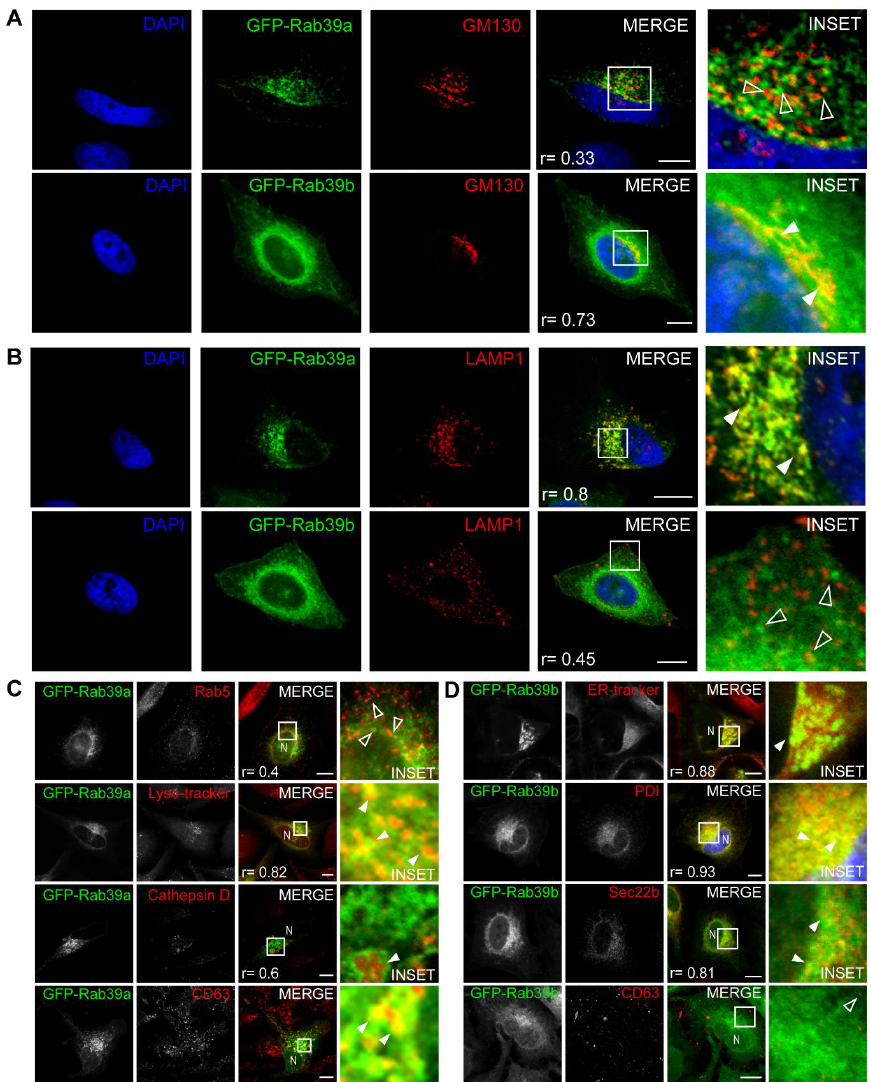
Figure 2. Rab39a and Rab39b intracellular distribution. ( A , B ) HeLa cells overexpressing GFP-Rab39a ( top ) or GFP-Rab39b ( bottom ) were incubated with anti-GM130 ( A ) to detect the cis -Golgi matrix protein or with anti-LAMP1 ( B ) to detect late endosomes. Cy3-labeled IgG was used as secondary antibody (red). DNA was stained with DAPI (blue). ( C ) Labeling of different intracellular structures of the endocytic pathway with typical probes (lyso-tracker) or specific antibodies (Rab5, Cathepsin D or CD63) followed by the appropriated secondary Cy3-coupled IgG (red) in HeLa cells overexpressing GFP-Rab39a. N indicates nuclei. ( D ) Identification of different intracellular organelles of the secretory pathway with typical probes (ER-tracker) or specific antibodies (PDI, Sec22b or CD63) followed by the appropriated secondary Cy3-coupled IgG (red) in HeLa cells overexpressing GFP-Rab39b. N indicates nuclei. ( A – D ) Pearson coefficients (r) were calculated with the analysis of 30 cells with ImageJ for each condition. Open arrowheads show structures bearing a single marker, whereas filled arrowheads indicate colocalization between two labels. Images are representative of three independent experiments. Scale bars represent 10 µ